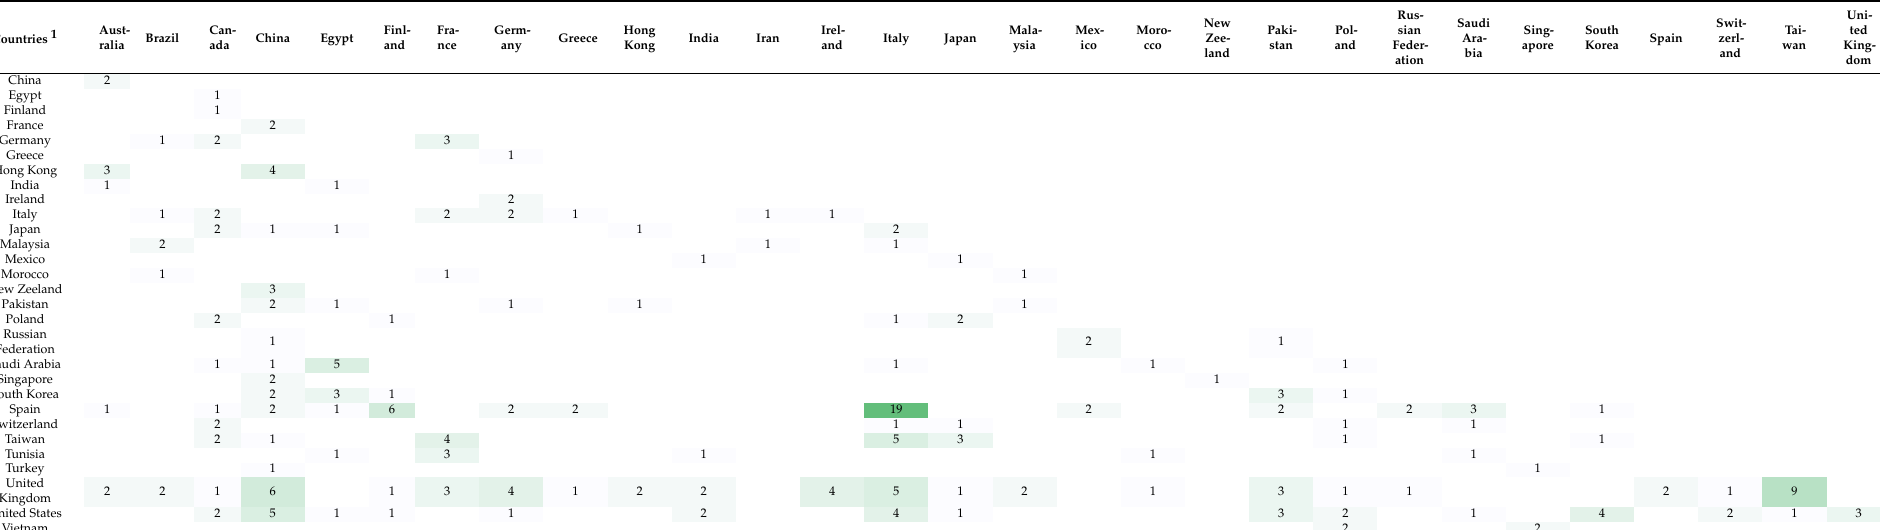
Table 5. Scopus co-occurrence of the countries in the ontology- and fuzzy-based IS